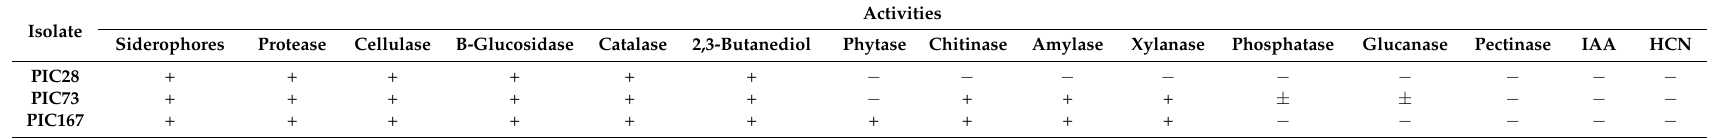
Table 3. Screening of activities associated with plant growth promotion or biocontrol in Bacillales